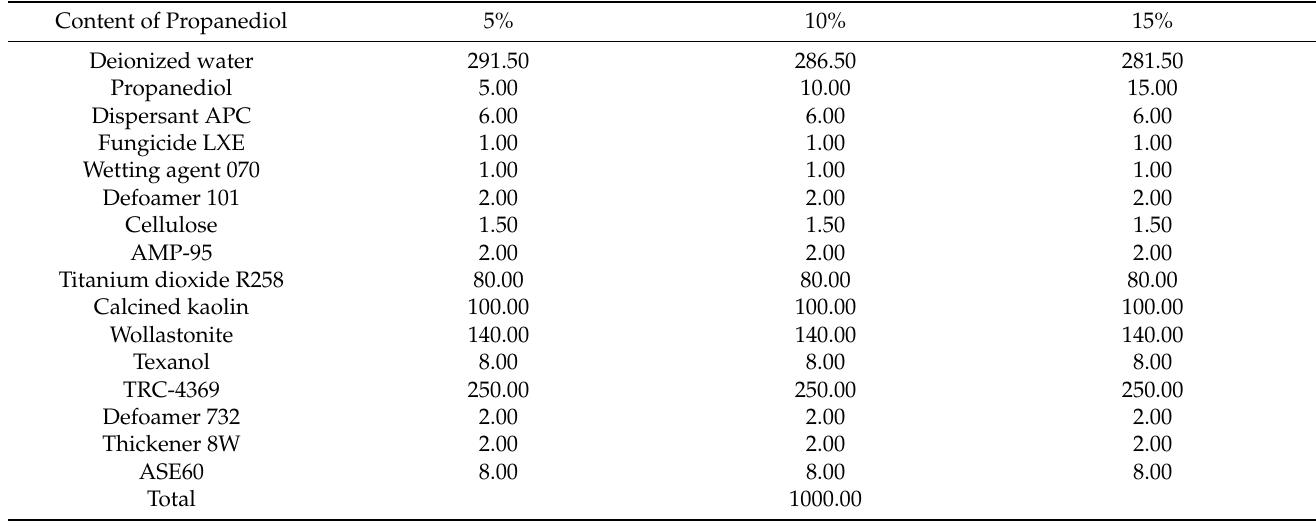
Table 6. Compositions of the paints for Design 3 (cosolvents).